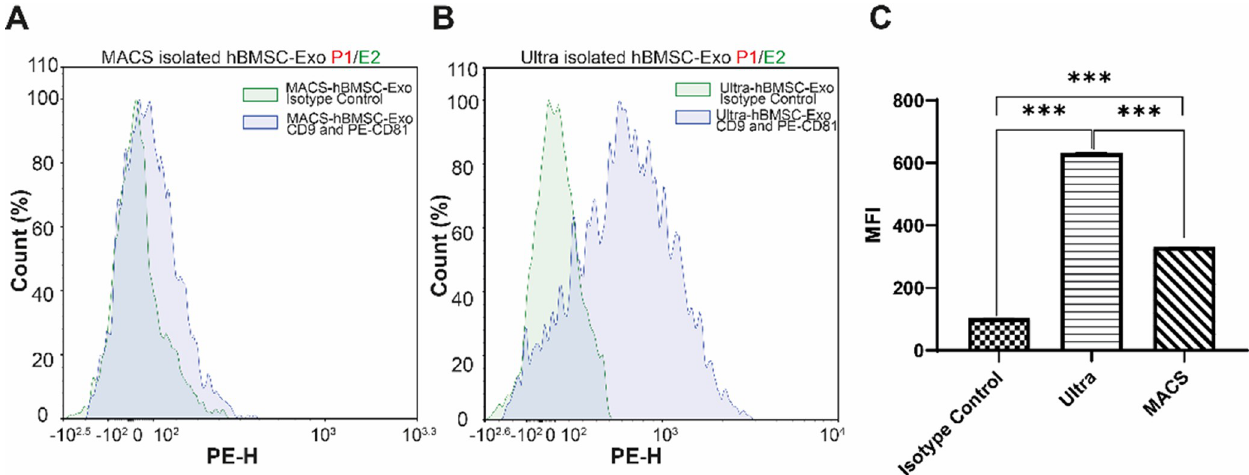
Fig 2. Flow cytometric analysis of exosomes. CD9 and CD81 surface expression on exosomes isolated by (A) MACS and (B) ultracentrifugation were analyzed by flow cytometry. (C) The MFI ratios of isotype control, ultracentrifuged, and MACS isolated- exosomes are shown. ��� indicates p < 0.001.